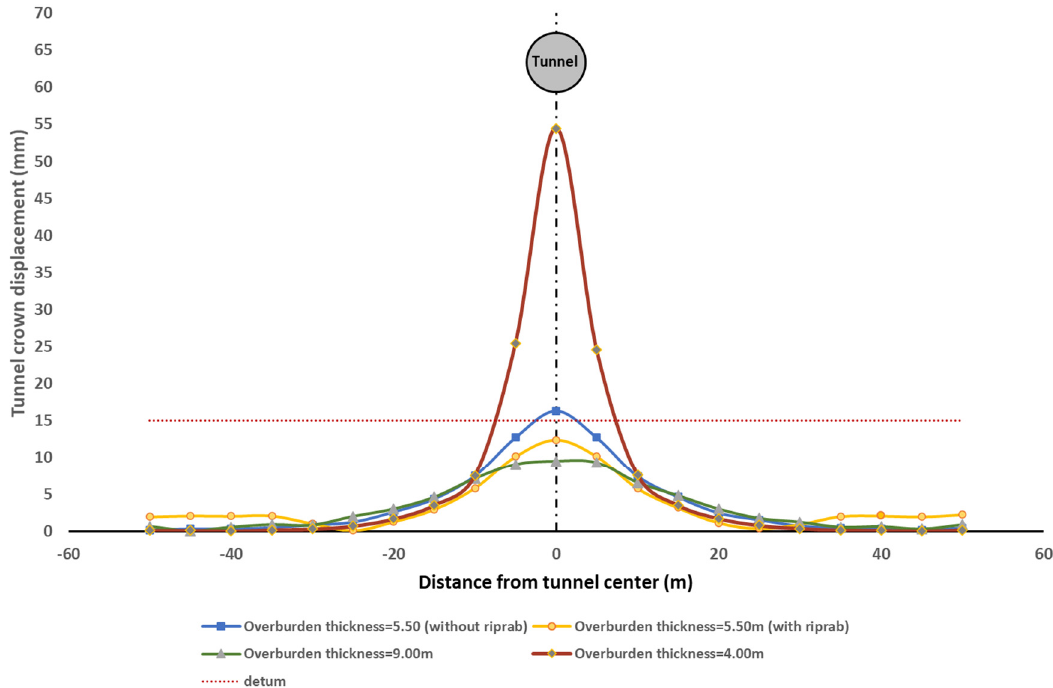
Figure 20. Horizontal surface settlement displacement and transverse trough during construction stage.